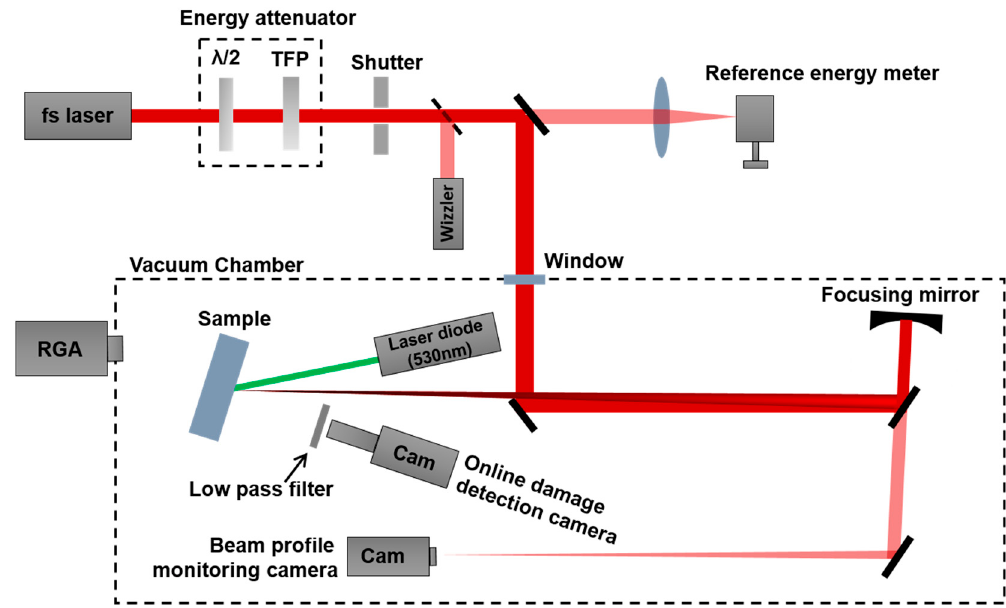
Figure 2. Schematic experimental setup of laser-induced damage resistance measurements. λ /2: half-wave plate, TFP: thin-film polarizer, RGA: residual gas analyzer and Cam: Camera.